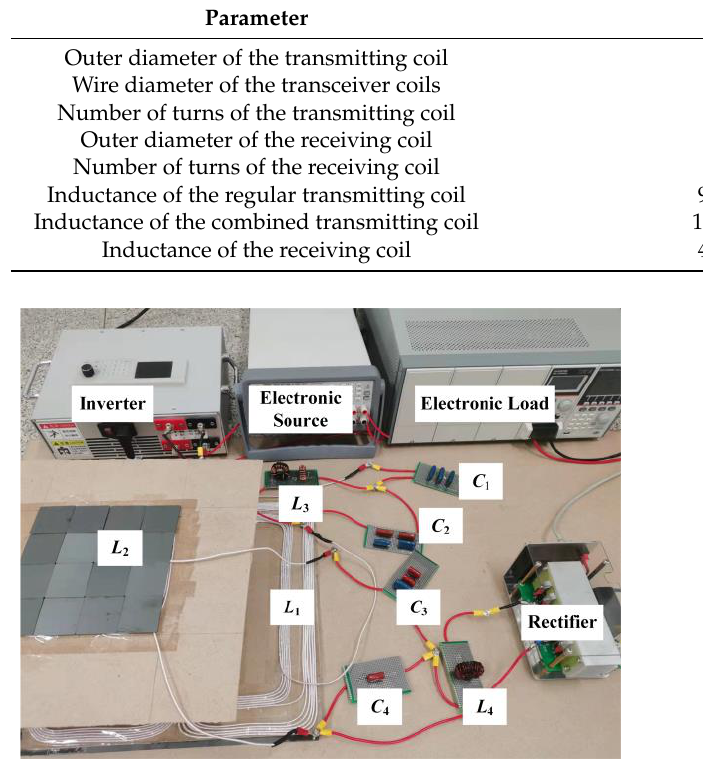
Table 3. Coil parameters.